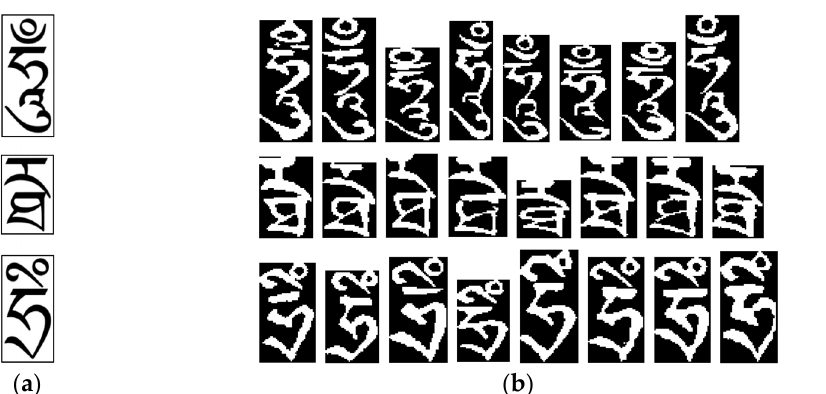
Figure 7. Example of synthesized character samples: ( a ) character text; ( b ) synthesized character image samples.